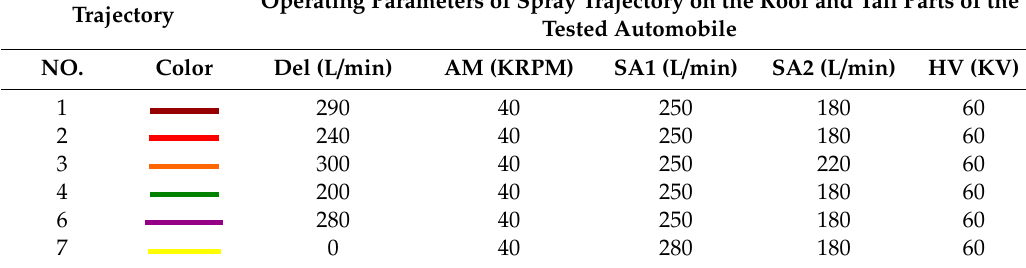
Table 1. Operating parameters of the spray painting trajectory on the roof and tail. Trajectory Operating Parameters of Spray Trajectory on the Left of the Tested Automobile Figure 16. Spray Painting trajectory on the right part of the automobile.